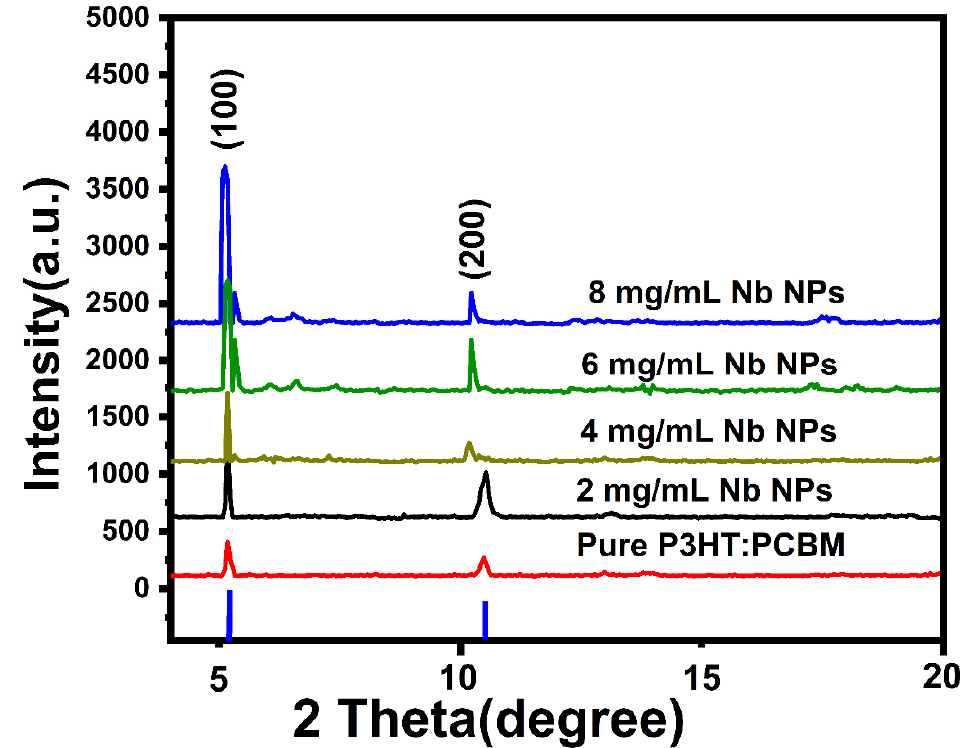
Figure 2. XRD patterns for pure P3HT:PCBM and P3HT:PCBM:Nb films fabricated using different Nb nanoparticle concentrations.